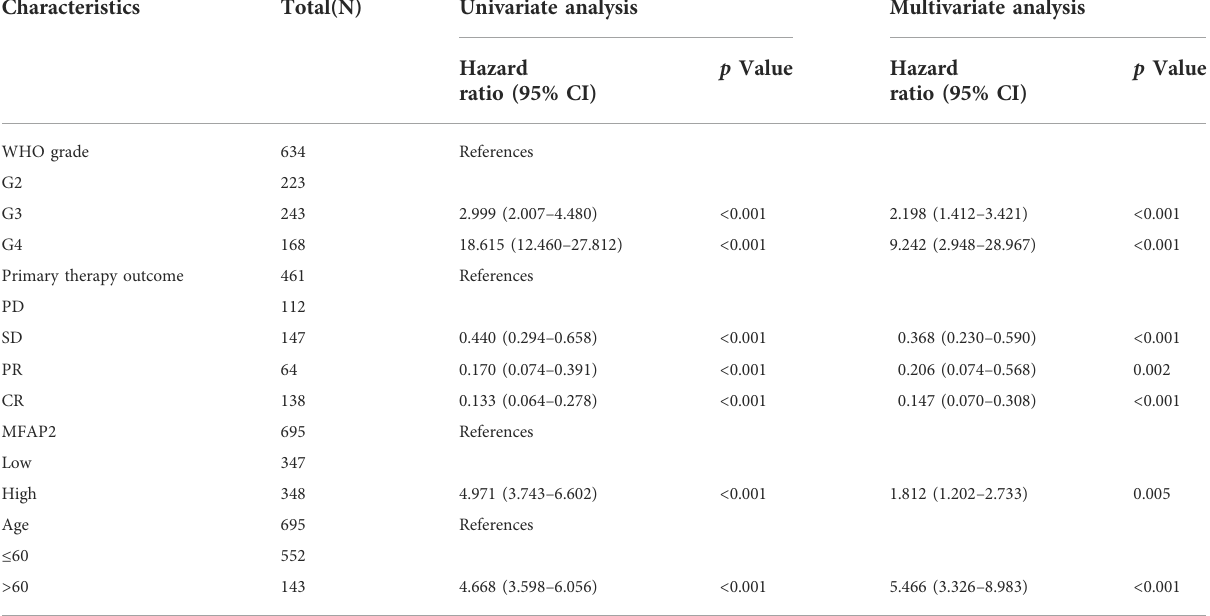
TABLE 2 Cox regression analysis for clinical outcomes in glioma patients.